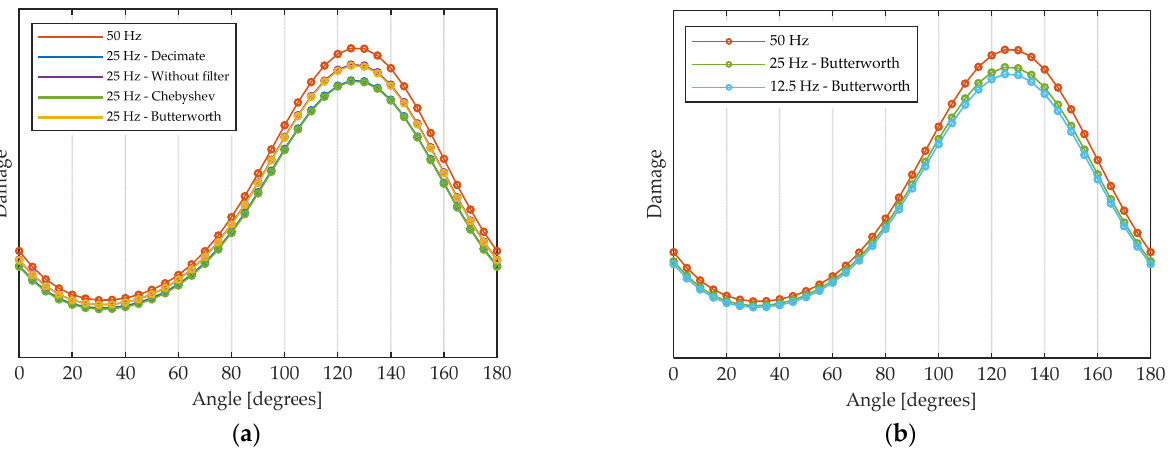
Figure 16. Influence of signal sampling frequency: ( a ) damage distribution over the section considering tree methods ( f s = 25 Hz); and ( b ) damage distribution over the section for all sampling frequency (Butterworth filter). Y scale omitted because of confidentiality agreements. Table 2. Relative differences of accumulated damage at the critical angle of the cross section of the tower considering the different sampling methods and sampling frequencies